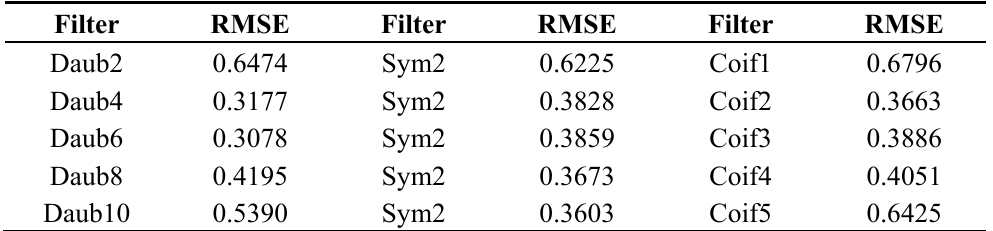
Table 3. RMSE between experimental fluorescence spectrum of 3 components (MLT, PNH and DMLT) and reconstructed signal by DWT with different filters and resolution level J = 3 (CR =